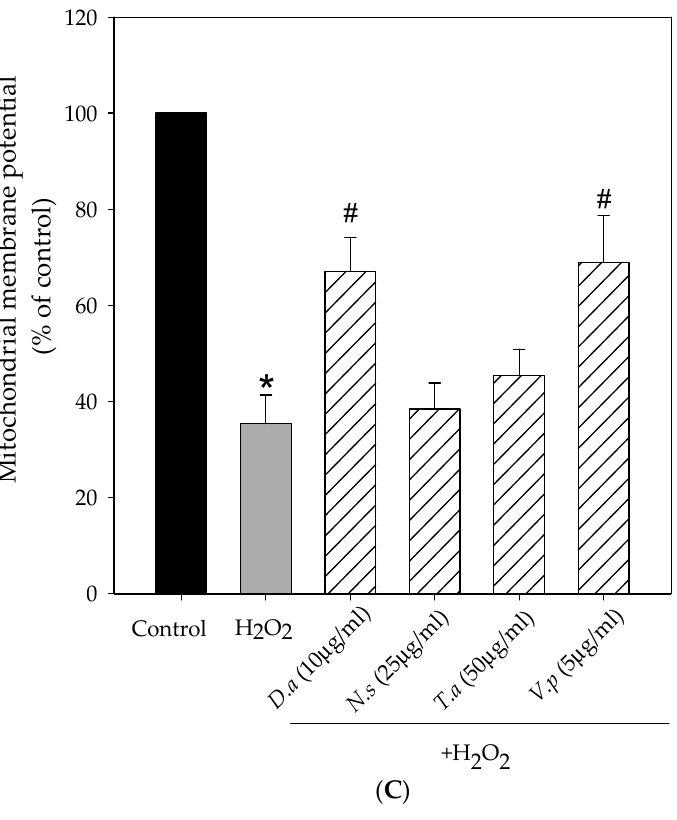
Figure 5. Effect of lichen extracts against H 2 O 2 -induced mitochondrial dysfunction in SH-SY5Y. ( A ) on cytosolic calcium levels. ( B ) on mitochondrial calcium levels. ( C ) on mitochondrial membrane potential. Data are expressed as means ± SD (% of control) * p < 0.001 vs. control; # p < 0.001 vs. H 2 O 2 ).